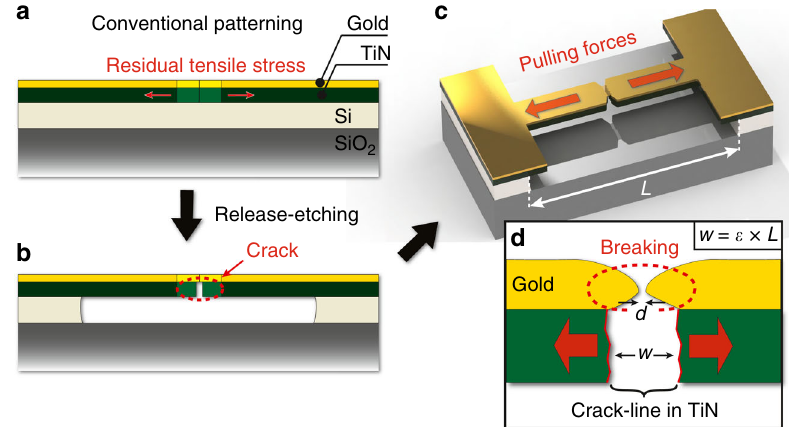
Fig. 1 Schematics of the proposed methodology to form crack-de fi ned break junctions. a A pre-stressed notched titanium nitride (TiN) bridge structure coated with a thin layer of gold is patterned; b the release-etching of the bridge structure induces the formation of a crack in TiN. c The formed TiN cantilevers retract and pull apart the section of gold located above the crack-line. d The pulling action w , de fi ned by the length L of the bridge, causes necking of the ductile gold; for a suf fi ciently large w , the gold breaks, thereby forming a nanogap with an inter-electrode separation